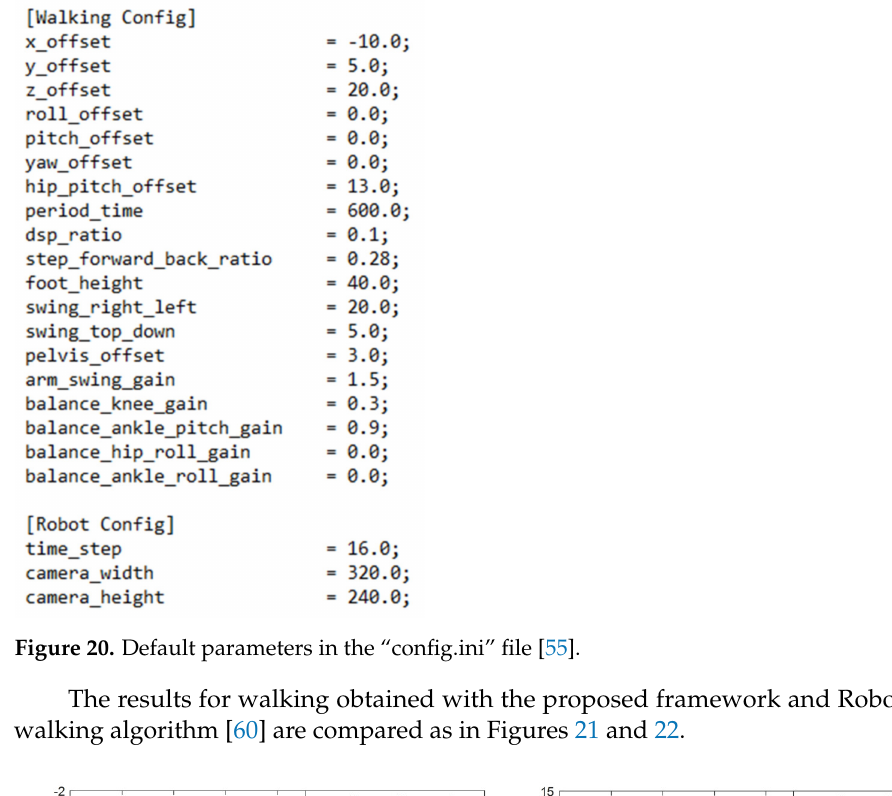
Table 9. The ranges of orientation angles for two methods.